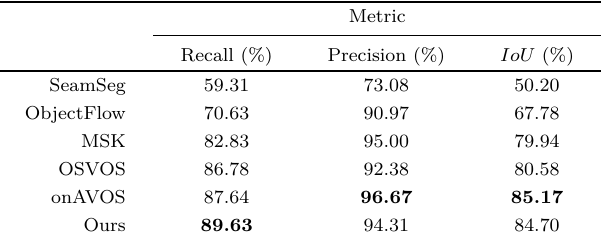
Table 1 Quantitative comparison of our object segmentation method to other state-of-the-art methods, on the single object DAVIS-2016 [7] validation set. The main objective when performing object removal is to achieve high recall scores